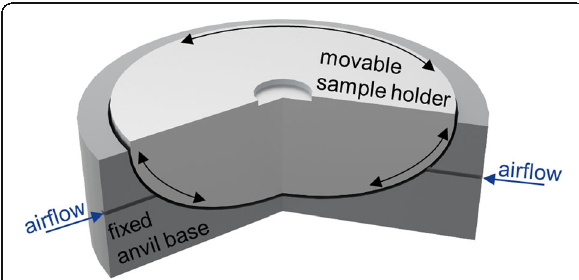
Fig. 4 CAD model of the equipped air beared anvil with self- adjusting sample holder